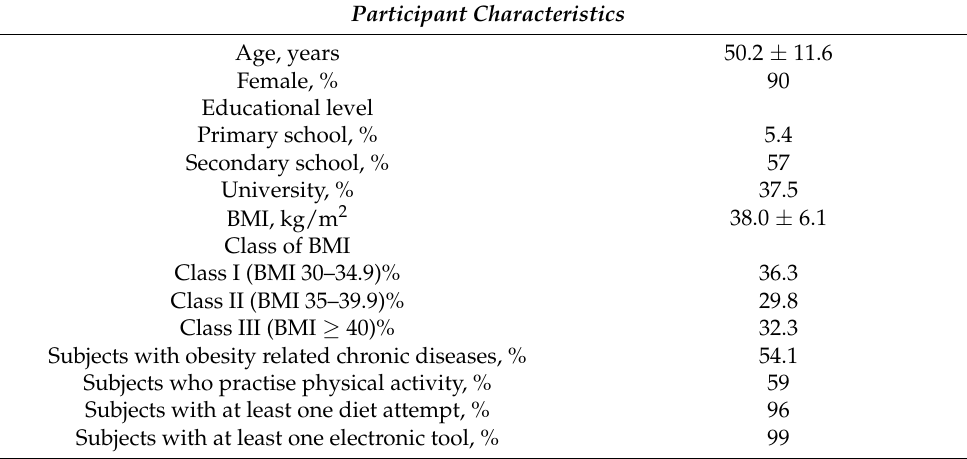
Table 1. Characteristics of 406 subjects with obesity who answered the questionnaire.